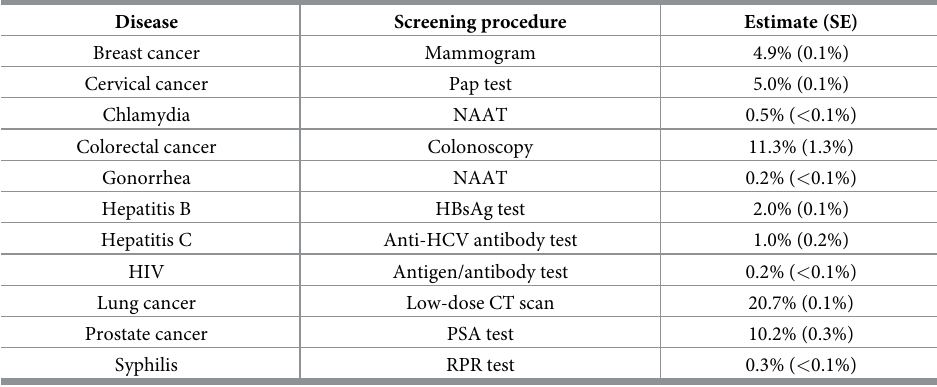
Table 1. Estimated false positive probability of one screening